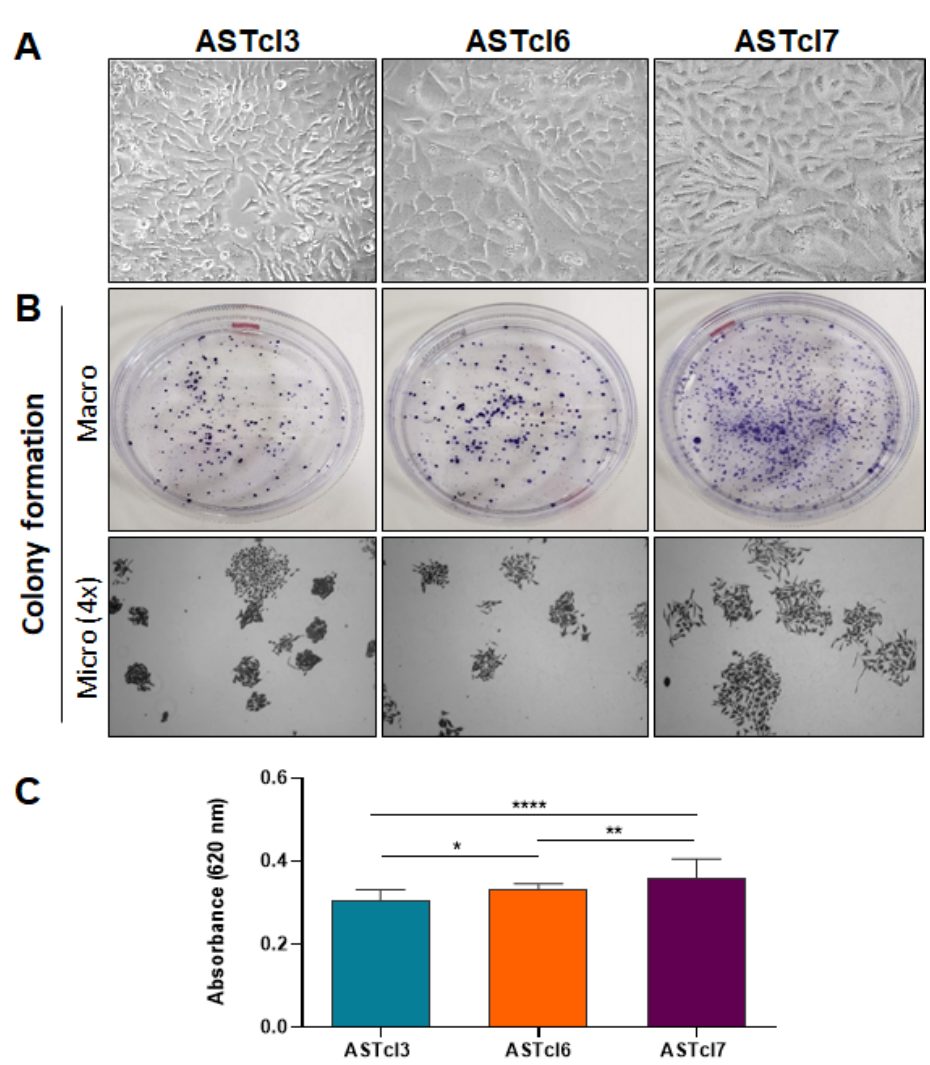
Figure 2. Clones obtained after subjecting primary astrocytes to sequential cycles of deadhesion/readhesion presented altered cellular morphology and colony-formation capability: ( A ) Photomicrographs of cell cultures of ASTcl3 (clone 3), ASTcl6 (clone 6), and ASTcl7 (clone 7). ( B ) Colony formation after 10 days, stained with crystal violet, and shown in a micro view and at a magnification of 4×. ( C ) Graph representing the mean ± standard deviation of four replicates of two independent colony-formation experiments after colorimetric measures of stained colonies. The asterisks indicate statistically significant differences: * p < 0.5, ** p < 0.01, **** p < 0.0001.